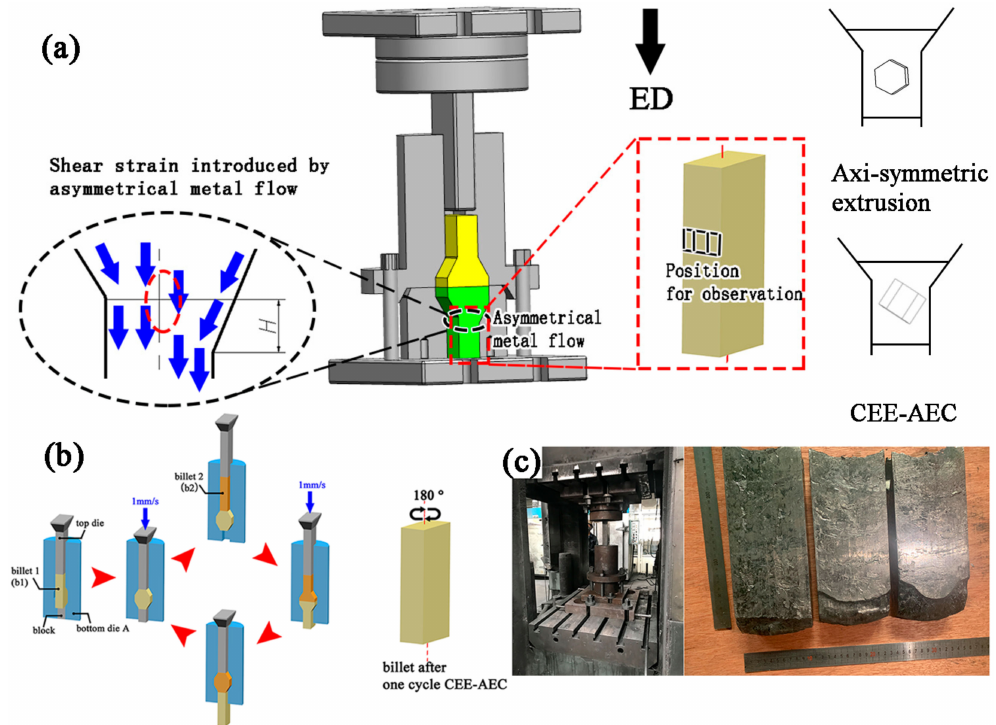
Figure 2. Schematic illustration of the cyclic expansion extrusion with an asymmetrical extrusion cavity (CEE-AEC) process: ( a ) deformation molds, ( b ) one-cycle deformation, and ( c ) specific dies and processed